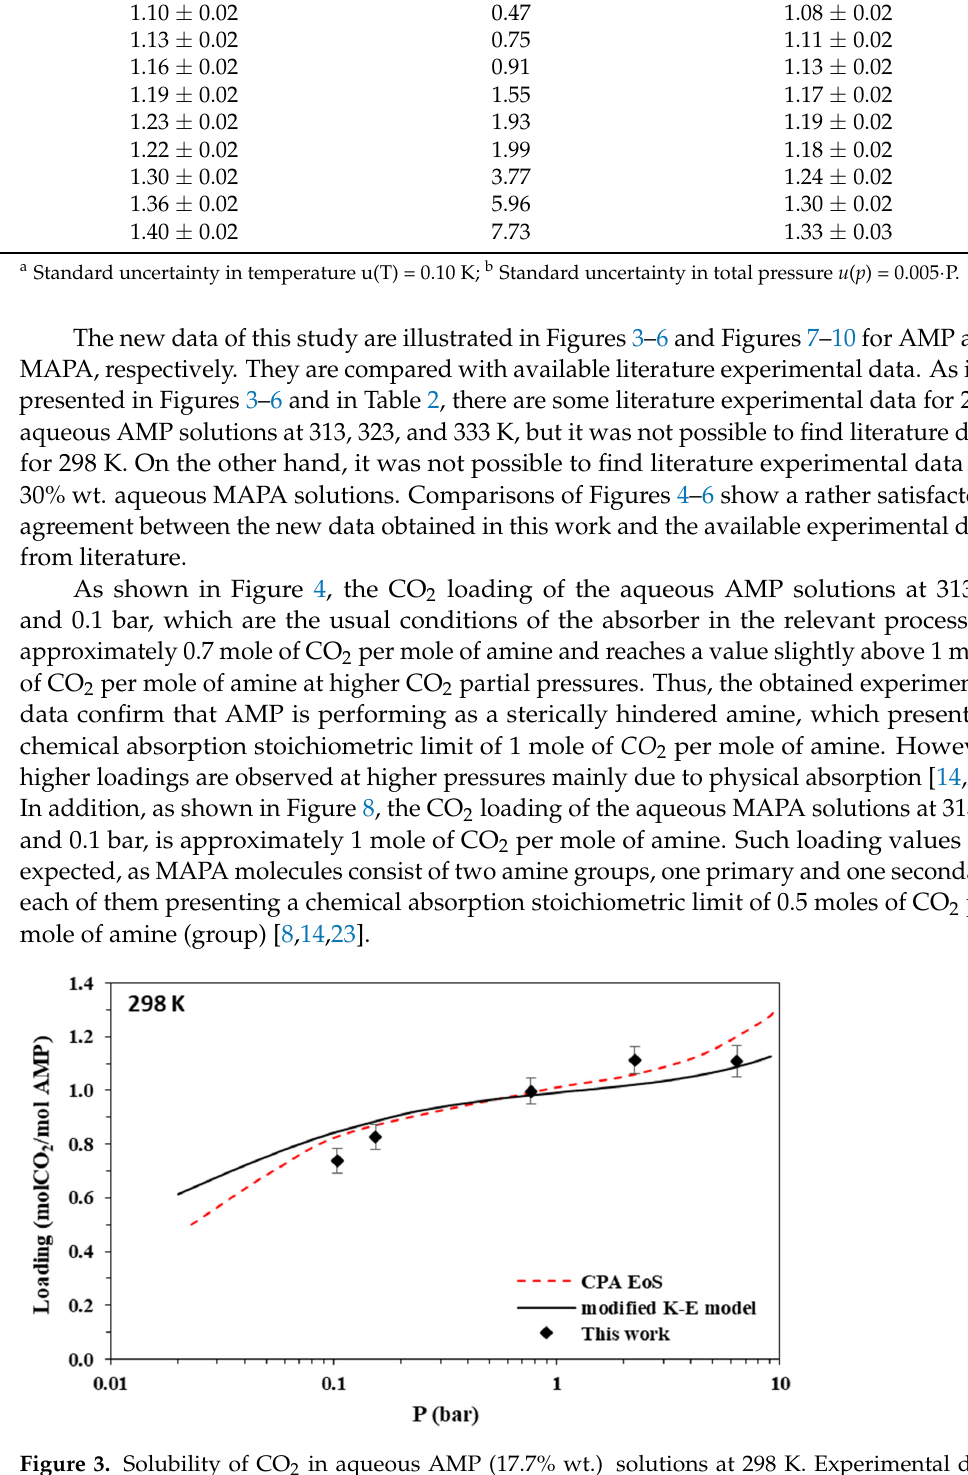
Figure 3. Solubility of CO 2 in aqueous AMP (17.7% wt.) solutions at 298 K. Experimental data (points, from this work) and correlations (lines) with the CPA equation of state and the modified Kent–Eisenberg model.